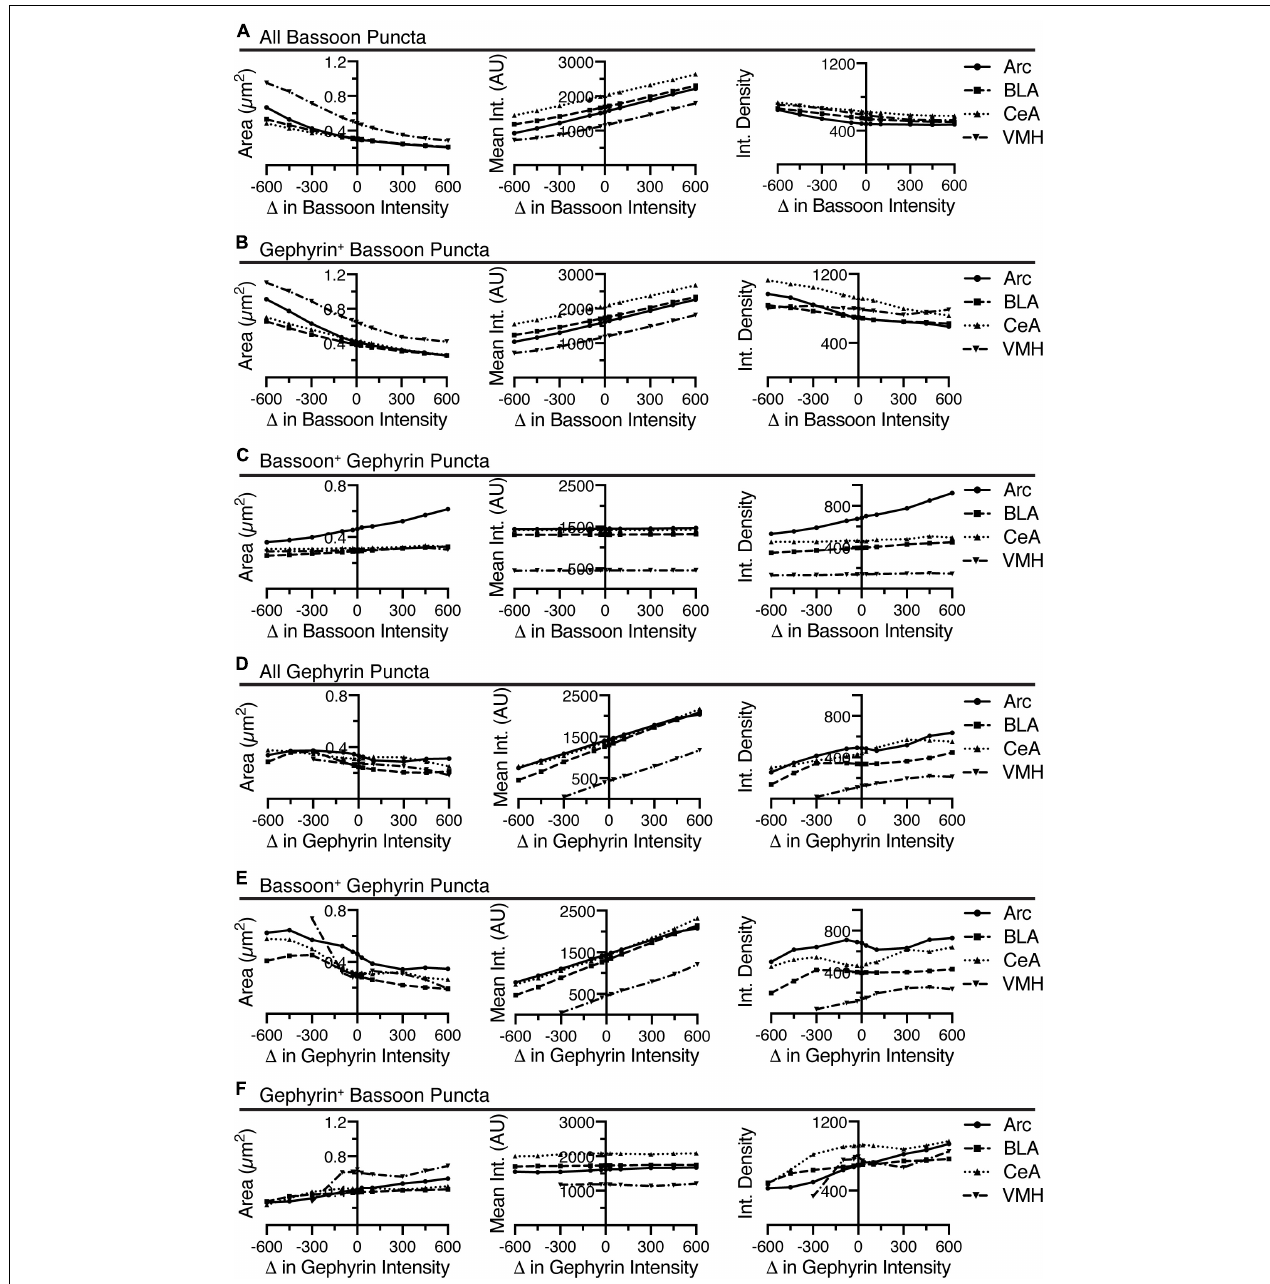
FIGURE 5 | Increasing the threshold intensity for identification of bassoon or gephyrin, generally decreased area, increased mean intensity, and decreased integrated density for bassoon and gephyrin puncta, respectively, with inconsistent effects on associated gephyrin or bassoon puncta. Changes in size (area, µ m 2 ), average intensity, and integrated density of all bassoon puncta (A) , gephyrin-positive bassoon puncta (B) , and bassoon-positive gephyrin puncta (C) are plotted vs. changes in threshold intensity for identification of bassoon puncta. Similarly, changes in size (area, µ m 2 ), average intensity, and integrated density of all gephyrin puncta (D)